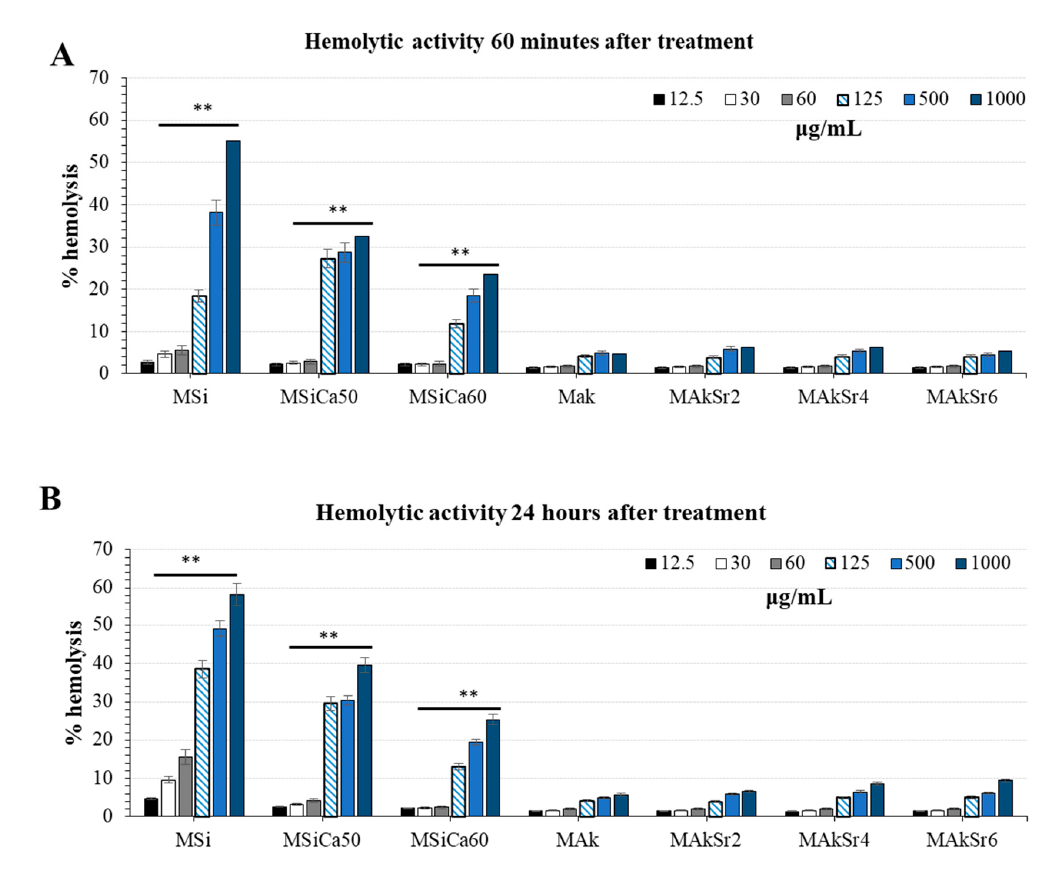
Figure 11. Hemolysis of human red blood cells (RBCs) upon incubation with mesoporous silica-based nanoparticles (MSNs) at different concentrations (12.5, 30, 60, 125, 500 µ g/mL) and 37 ( A ) after 60 min and ( B ) after 24 h of incubation. The results are expressed as % of positive control (hemolysis buffer). Data are mean ± SD (n = 10 in each group). ** indicates statistically significant difference ( p < 0.001).